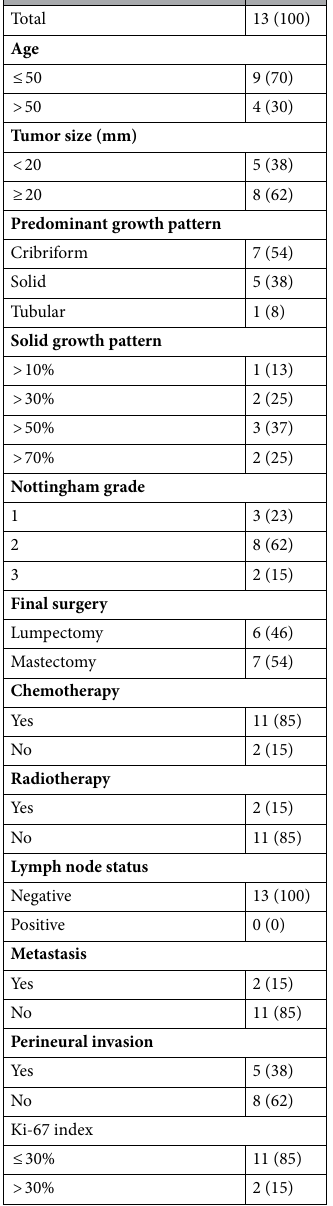
Table 1. Clinicopathologic parameters of the breast AdCC